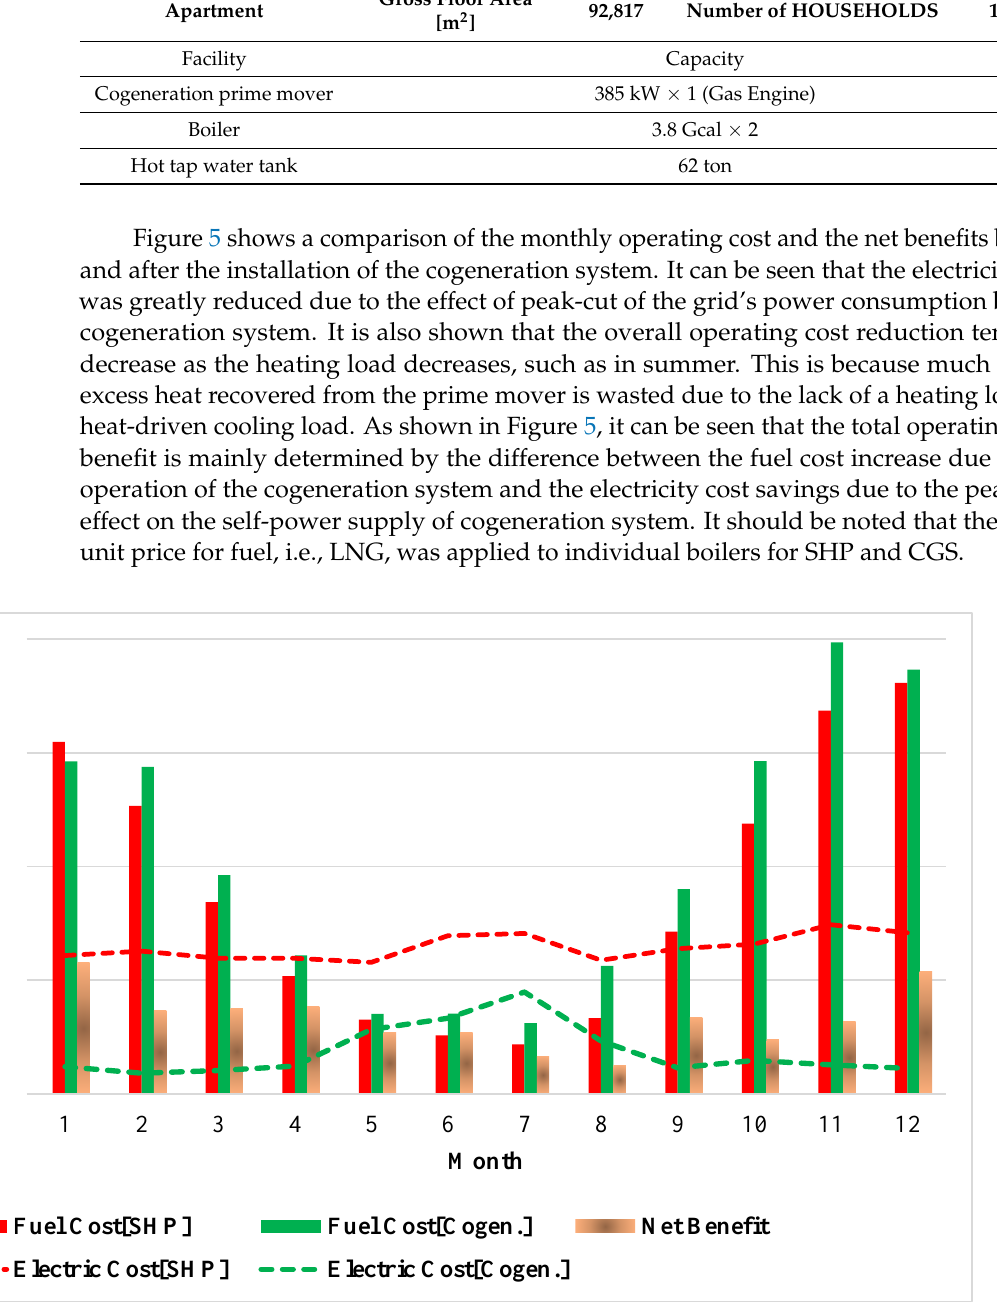
Table 2. Design information for the apartment complex and the cogeneration system configuration for Case A.